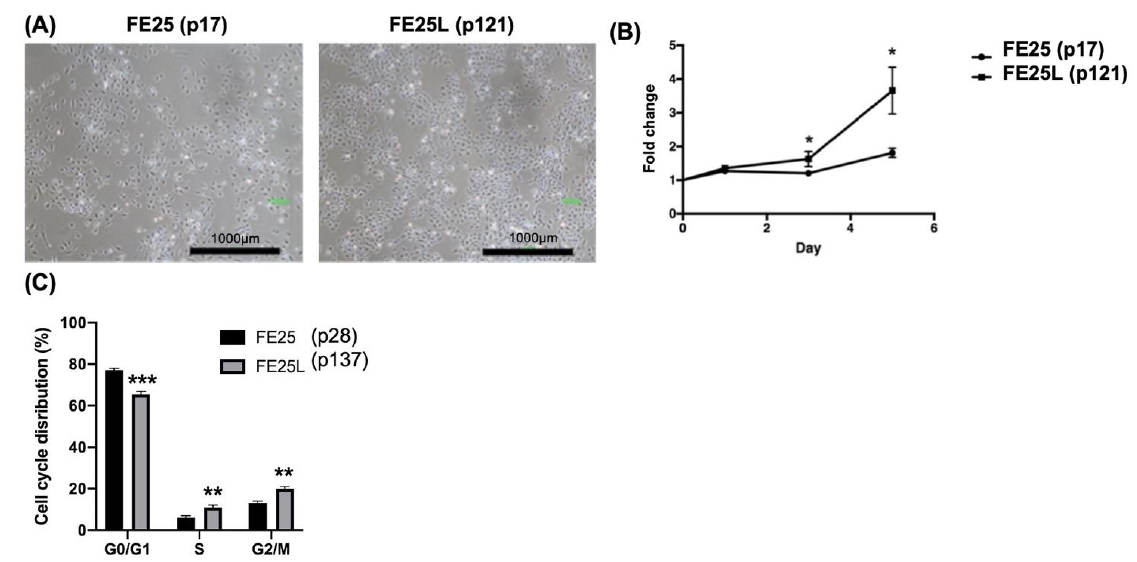
Figure 1. The characteristics of FE25 (p17) and FE25L (p121) cells. ( A ) The morphology of FE25 and FE25L cells. Scale bar = 1000 µm. ( B ) Proliferation curve of the FE25 and FE25L cells over 5 days ( n = 3 in each group). The error bars represent standard deviation (SD). Data were expressed as fold change in cell numbers compared to day 0 (value = 1). * p < 0.05. ( C ) Distribution curves showing quantitative proportion of the cells in each cell cycle in at least 10,000 cells of each sample ( n = 3). The error bar represents the mean ± SD. All the experiments were performed in triplicates. ** p < 0.01, *** p < 0.001.